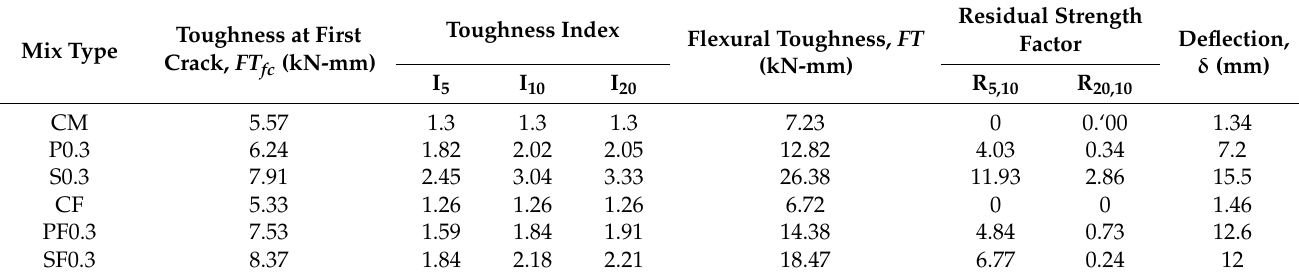
Table 5. Post cracking characteristics of concrete, determined according to ASTM1018 [30].